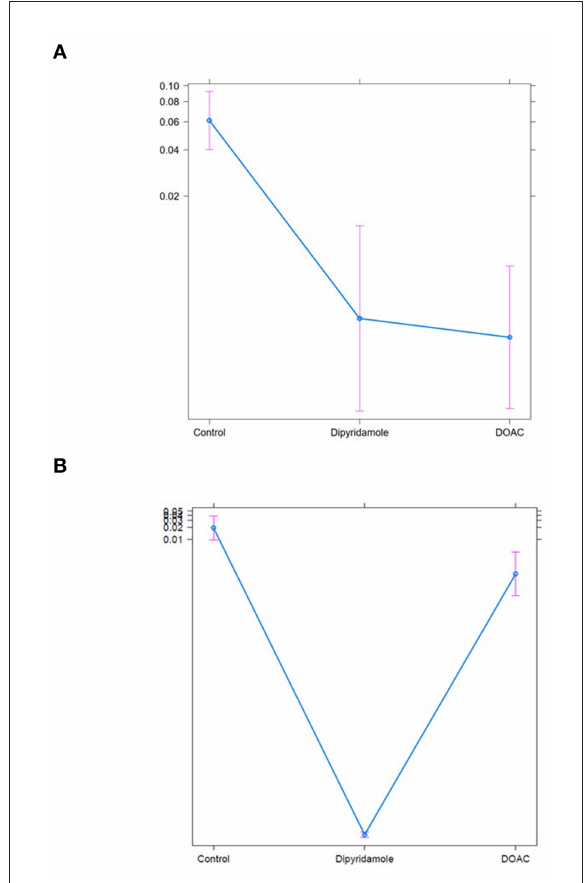
FIGURE7 Treat effect plots of weighted binary logistic regression regarding the predefined study endpoints, depicted are predicted probabilities and 95% CI: (A) all-cause mortality [predicted probabilities: Ctrl.: 6.1% (95% CI 4.0–9.2) vs. Dipyridamole: 0.3% (95% CI 0.1–1.3) vs. DOAC: 0.2% (95% CI 0.1–0.7)], (B) cardiovascular mortlaity [predicted probabilities: Ctrl.: 0.02% (95% CI 0.01–0.4) vs. Dipyridamole < 0.01% (95% CI 0.0–0.1) vs. DOAC: < 0.01% (95% CI